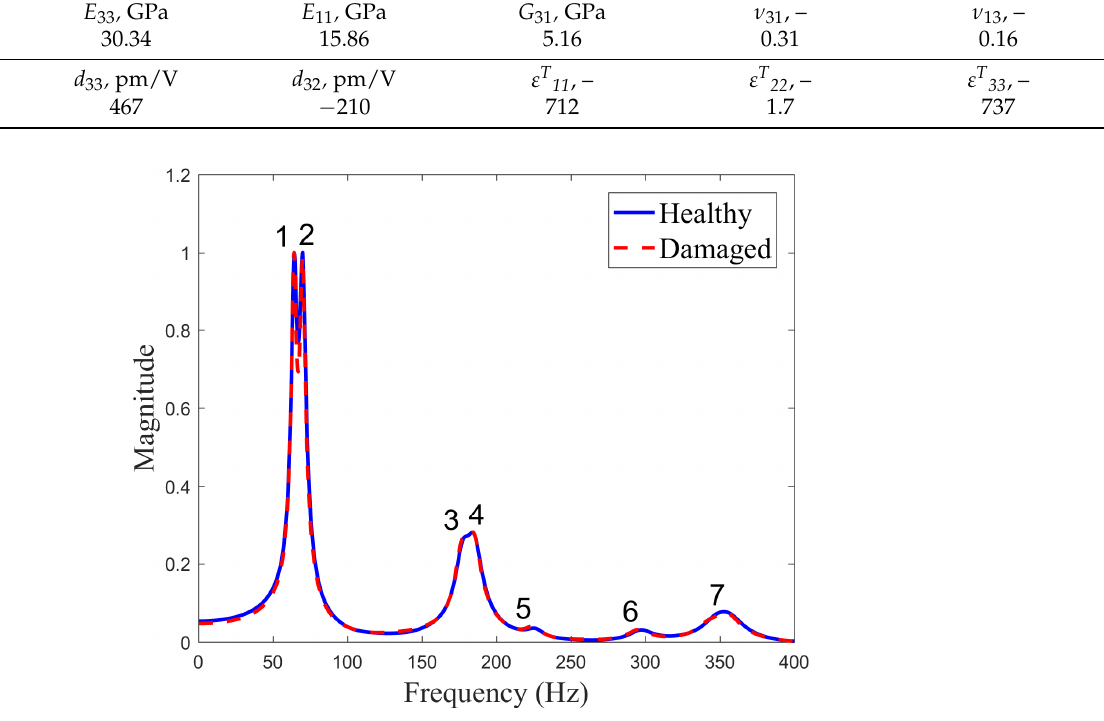
Figure 17. The numerically calculated FRF of CFRP plates. Table 6. The numerically determined resonant frequencies (Hz) and corresponding modes. No.